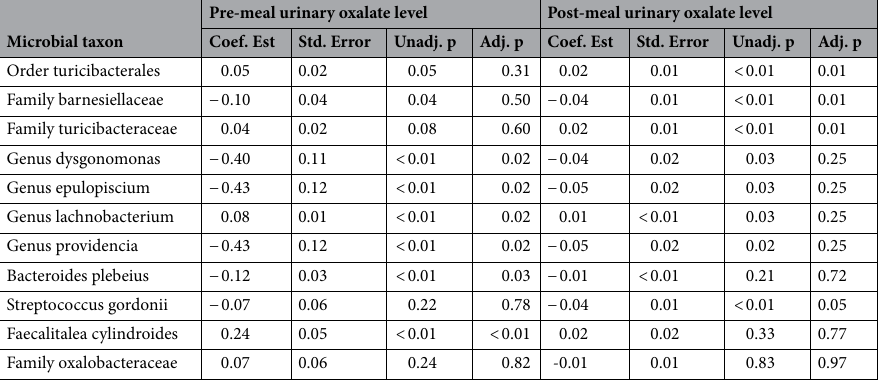
Table 2. Microbial taxa associated with pre/post-dietary urinary oxalate level in antibiotic-treated subjects. The estimated regression coefficients, standard errors, and unadjusted/adjusted p-values for the effect of the relative abundance of individual microbial taxa with centered log-ratio transformation in fitted mixed effect models. Analysis adjusted for age, gender, ethnicity, BMI, and calcium level.